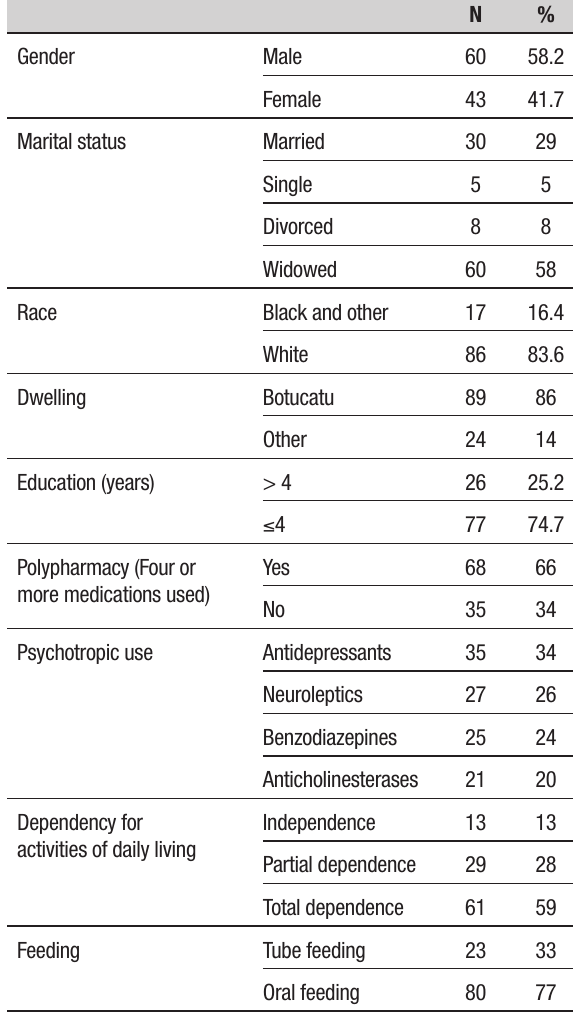
Table 1. Sociodemographic, functional capacity and pharmacological aspects of the sample.